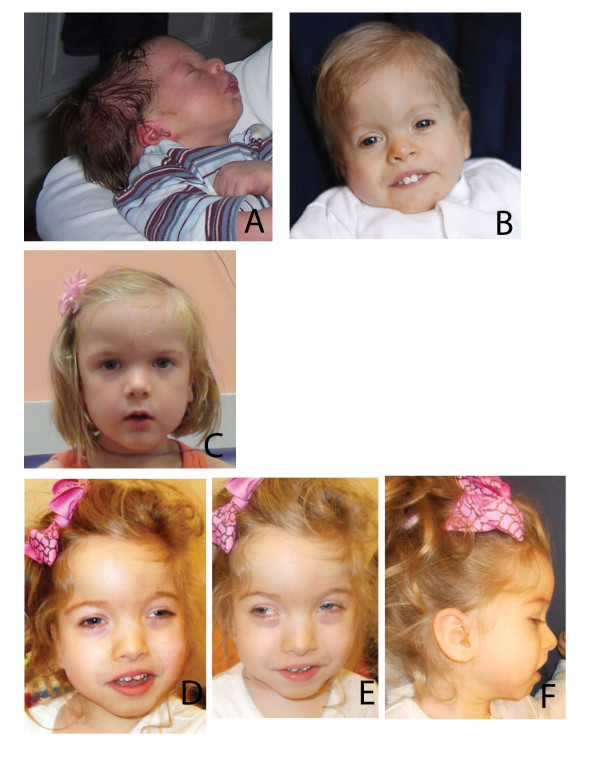
Clinical presentation of four subjects. (A, B) Subject 2 aged (A) 1 month and (B) 38.5 months. Note the high forehead, low-set ears, thin arched eyebrows and anteverted nares. (C) Subject 3, aged 5 years, Note high and broad forehead, periorbital fullness, and anteverted nares. (D-F) Subject 4, aged 41.5 months, showing prominent tall forehead, arched eyebrows with subtle synophrys and periorbital fullness, prominent columella with hypoplastic alae nasi, thin upper lip, and borderline low-set ears. Note that none of the patients has trigonocephaly or prominent metopic ridge, as seen in Boehring-Opitz syndrome. Images were not available for subject 1.